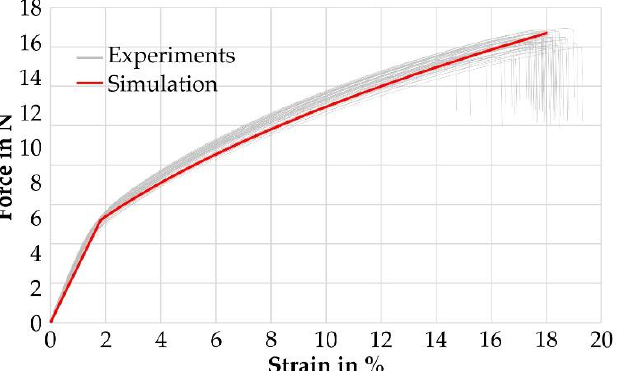
Figure 1. Results of tensile tests of 33 tex silk fibroin yarns and material model for simulation (material model is described in Section 2.4).